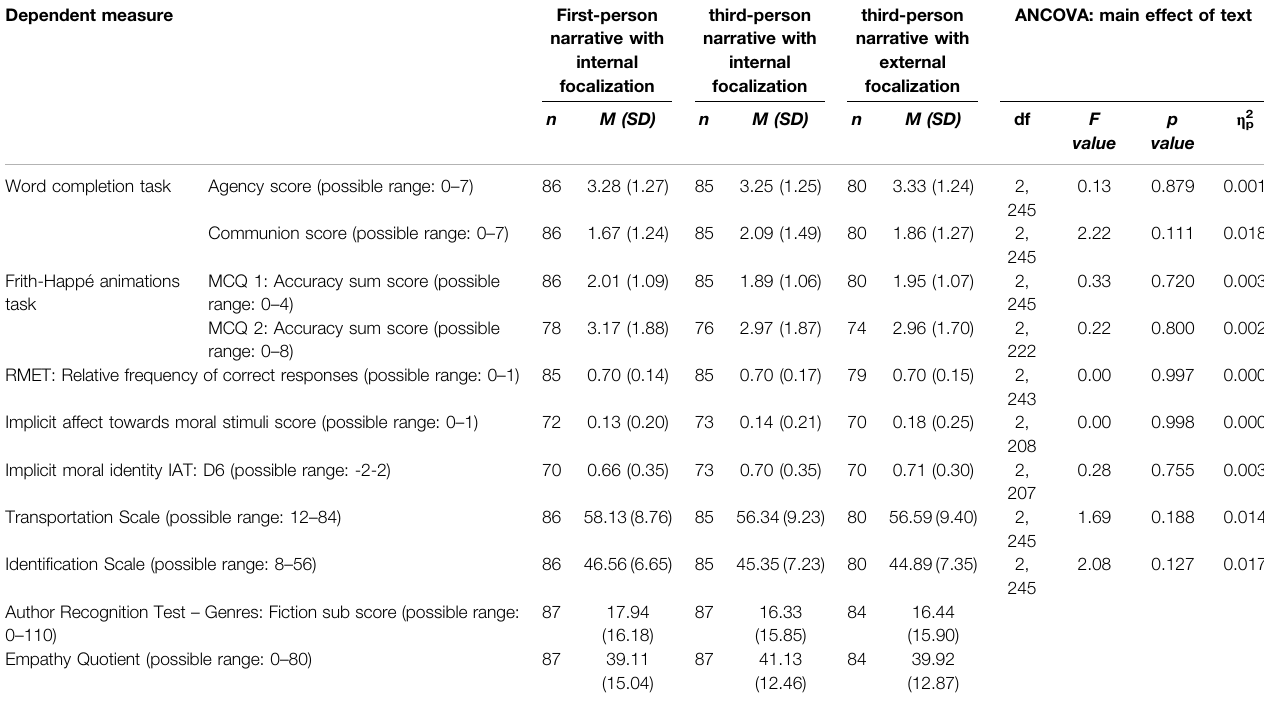
TABLE 3 | Experiment 1: Descriptive statistics for each dependent measure in each experimental group, and ANCOVA results for the main effect of text. Dependent